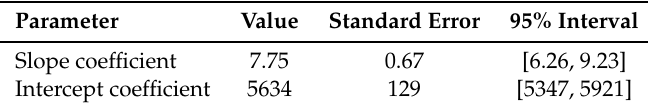
Table 2. Linear regression fit characteristics for data in Table 1. The coefficient of determination is R 2 = 0.93, which is identical to the IPMVP case. These results may be compared to Bayesian summary statistics in Table